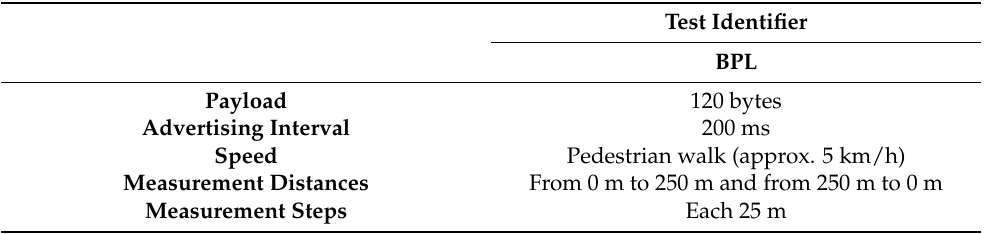
Table 8. Test configuration I2V coexistence scenario LE_CODED long distance.